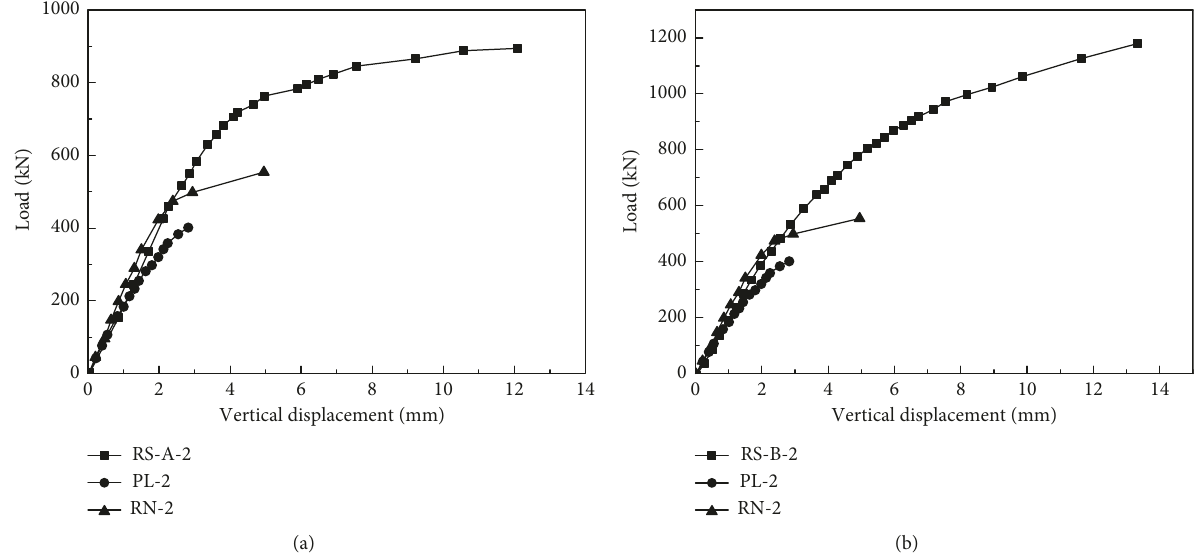
Figure 10: Comparison of plain concrete, reinforced concrete, and reinforced CFST